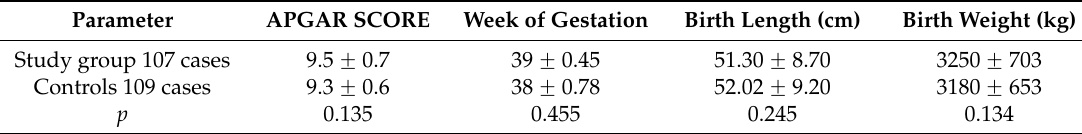
Table 4. Offspring characteristics in the study group compared with